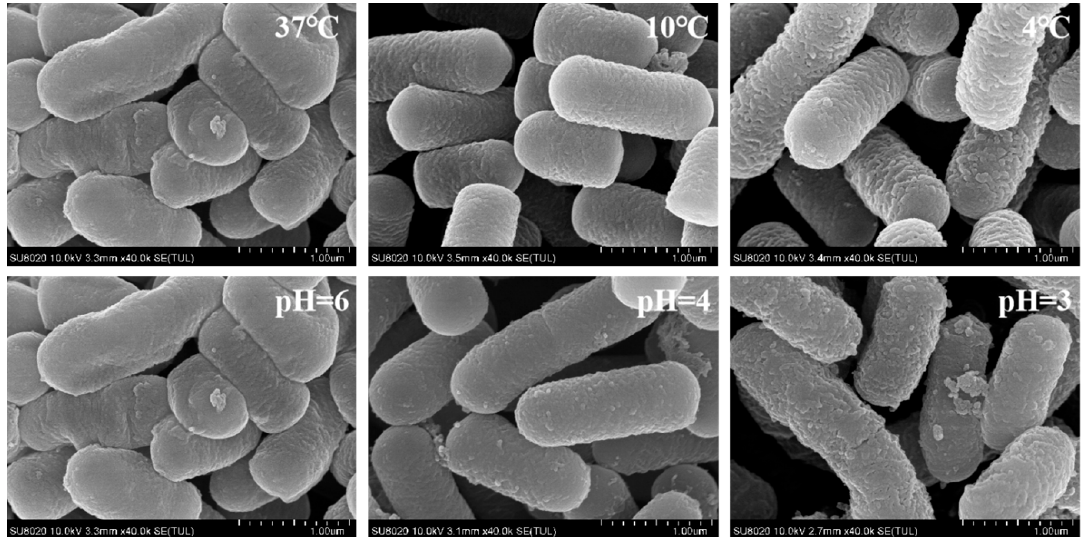
Figure 2. SEM images of Lpb. plantarum NMGL2 at different temperatures: 37 °C, 10 °C, and 4 °C and at pH 6.0, 4.0, and 3.0. The magnification was 1.00 µm.